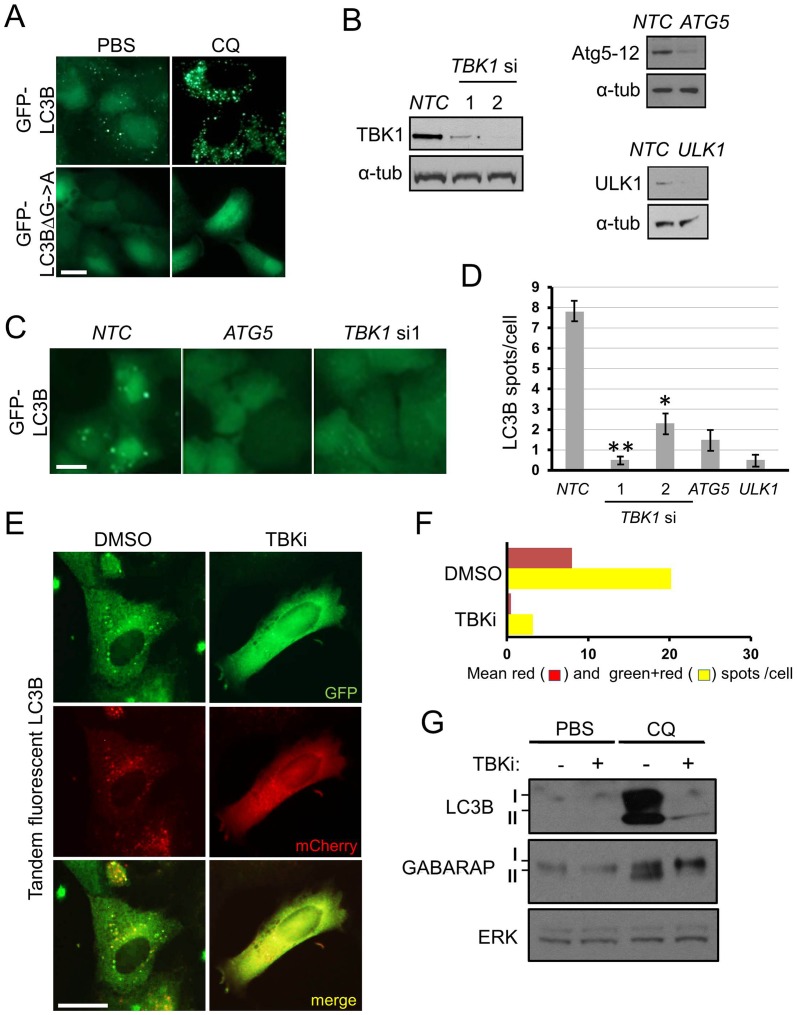
TBK1 kinase activity engages basal autophagy in A549 NSCLC cells. a)A549 GFP-LC3B or GFP-LC3BΔG->A cells were treated with PBS or 5 µM chloroquine (CQ) for 8 h and cells imaged for GFP. b, c) A549 GFP-LC3B cells were transfected with indicated siRNA for 72 h (NTC = non-targeting control) and b) cell extracts blotted for indicated proteins (α-tub = α-tubulin) or cells were c) imaged for GFP-LC3B puncta. d) A549 FLAG-HA-LC3B cells were transfected with indicated siRNA and HA-positive puncta immunostained, imaged and counted at 72 h (n = 3, ± S.E.M., * = p<0.05, ** = p<0.01). e,f) A549 tandem-fluorescent-LC3B (tfLC3B) cells were treated with DMSO or 1 µM MRT68601 (TBKi) for 24 h and e) imaged and f) quantified for total number of autophagic puncta (green+red) and the subset of these puncta with undetectable GFP signal (red), as described in detail in Materials and Methods. g) A549 cells were treated with DMSO or 10 µM MRT68601 (TBKi) for 24 h in the presence or absence of PBS or 5 µM (CQ) chloroquine and cell extracts blotted for indicated proteins. Scale bars = 50 µm in all panels.